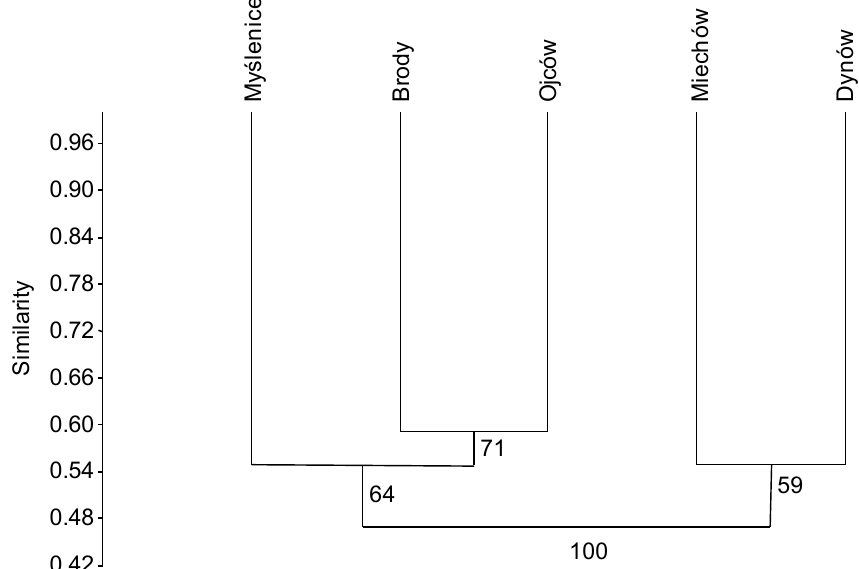
Figure 3. Similarity of fungal communities isolated from the previous year’s leaf petioles of F. excelsior in five stands shown by dendrogram based on Bray–Curtis similarity index.